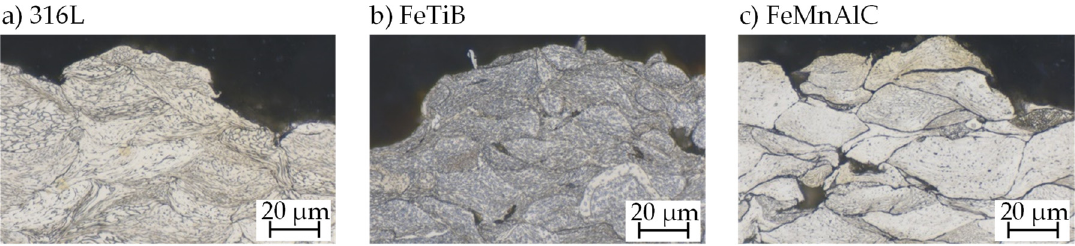
Figure 4. Microstructure of the cold sprayed samples: ( a ) etched 20 s in 60% electrolytic HNO 3 (1.5 V); ( b , c ) etched 15–20 s in 3% alcoholic HNO 3.